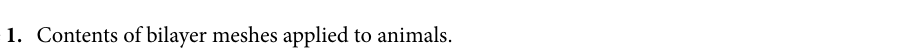
Table 1. Contents of bilayer meshes applied to